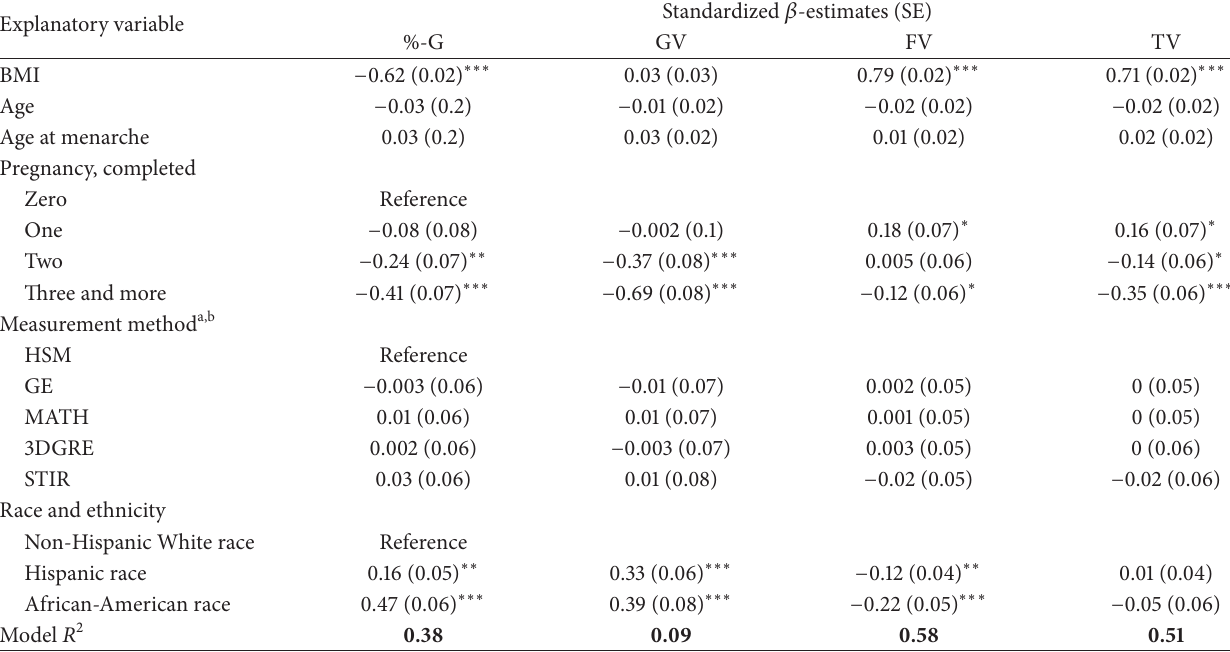
Table 5: Multivariate analysis model estimates for percent breast density (%-G), fibroglandular tissue volume (GV), fat tissue volume (FV), and total breast volume (TV) measured by five different methods ( 𝑛 = 320